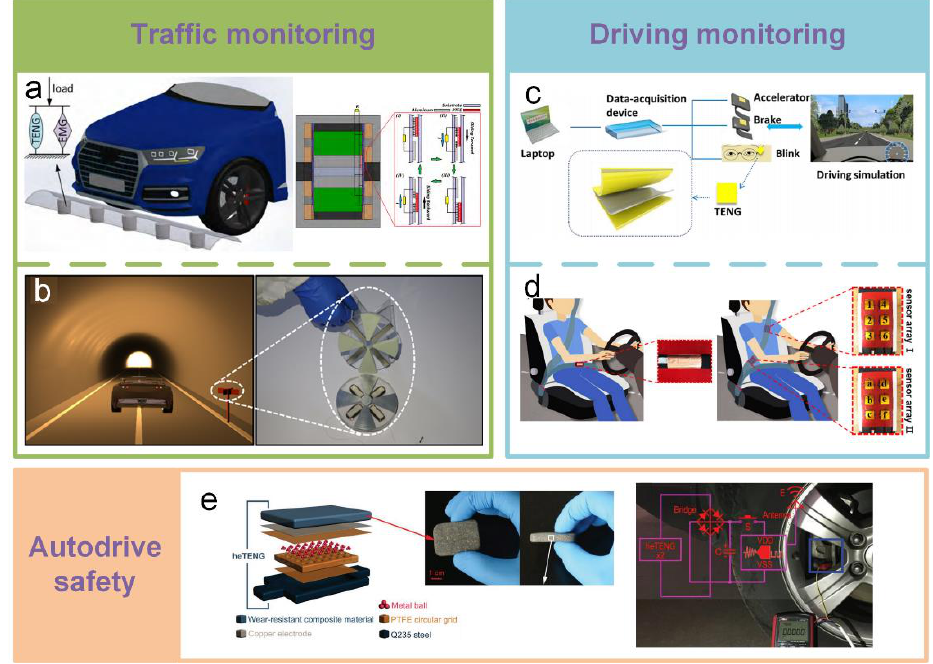
Figure 19. TENGs for smart traffic applications based on TENG. ( a ) A hybridized TE-EM